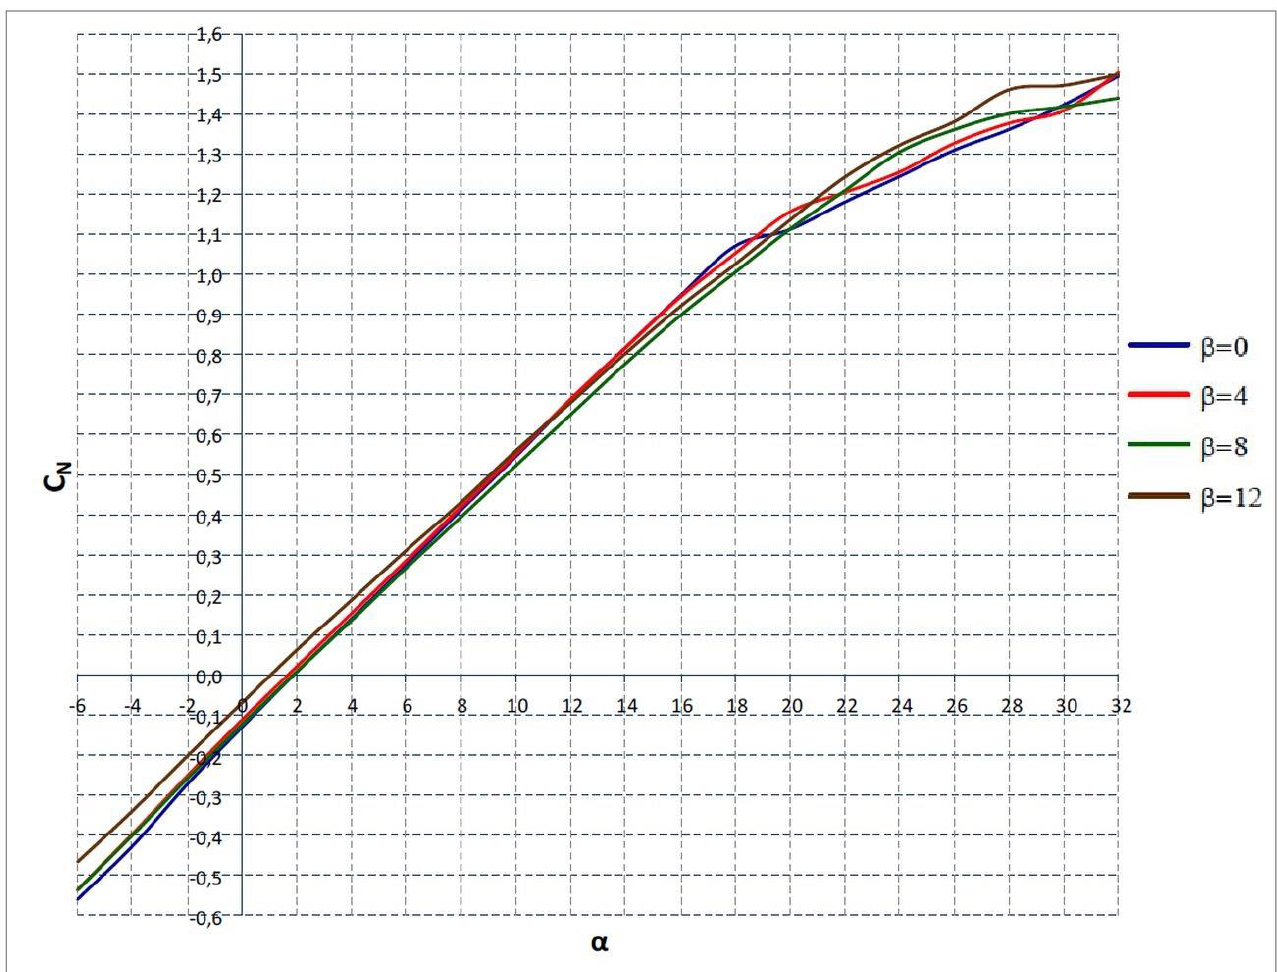
Figure 6. Dependence C N = f (α), for different sliding angles (β) for Reynolds number = 22,000 (Re) for FF model.